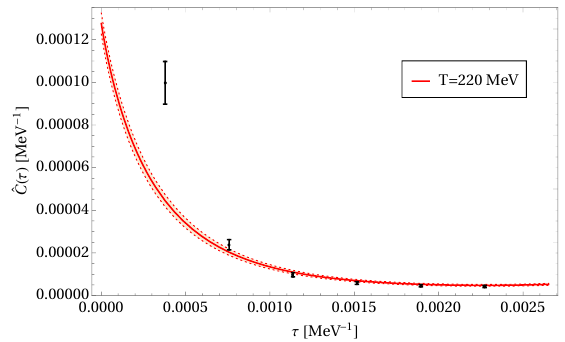
Figure 2: The ˆ C PS ( τ ) prediction against the rescaled lattice data (black points) for T = 220 MeV. The error bars and coloured band indicate the estimated combined